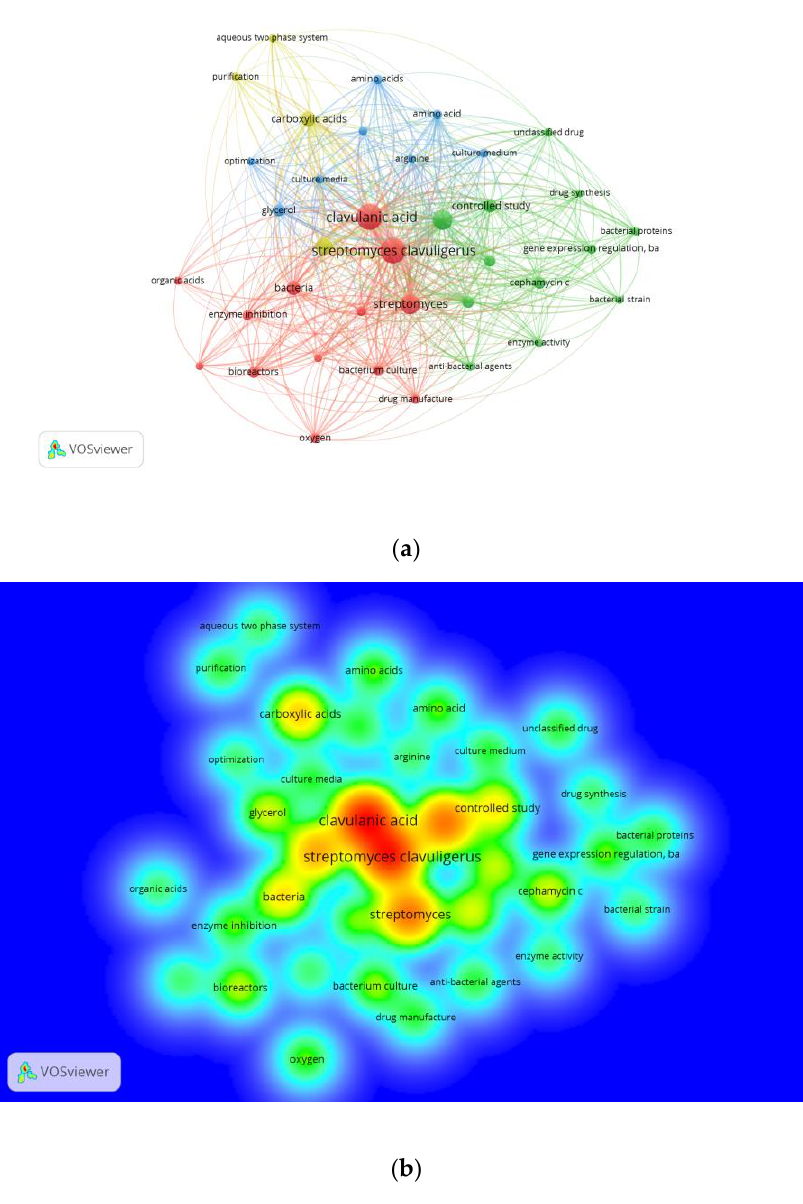
Figure 7. Publications about clavulanic acid production by Streptomyces clavuligerus in the chemical engineering discipline between 1976 and 2017. ( a ) Research-topic map for publications about clavulanic acid production by Streptomyces clavuligerus . ( b ) Research-topic density map for publications about clavulanic acid production by Streptomyces clavuligerus